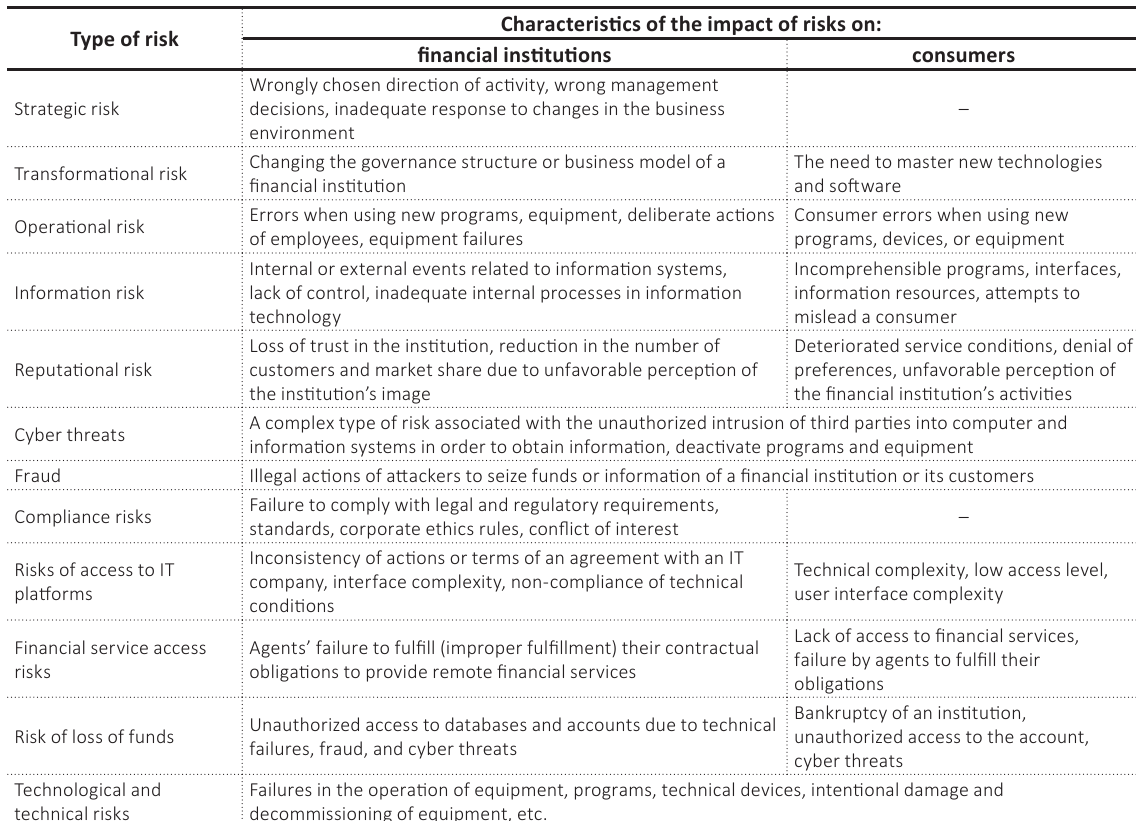
Source: Developed by the